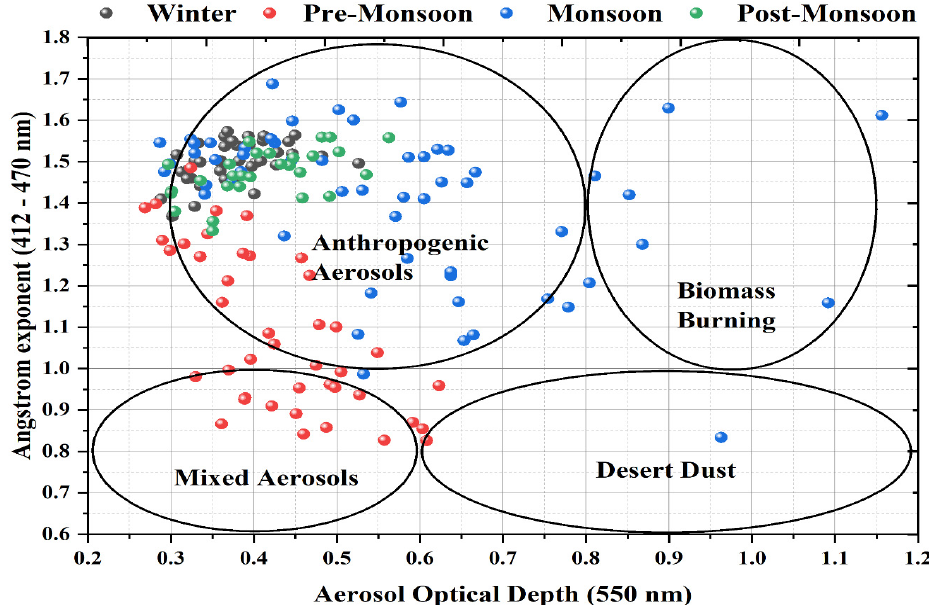
Figure 12. Scatter plot between the angstrom exponent (412–470 nm) and AOD (550 nm) for seasonally averaged values between the period 2000–2013 over the study region.